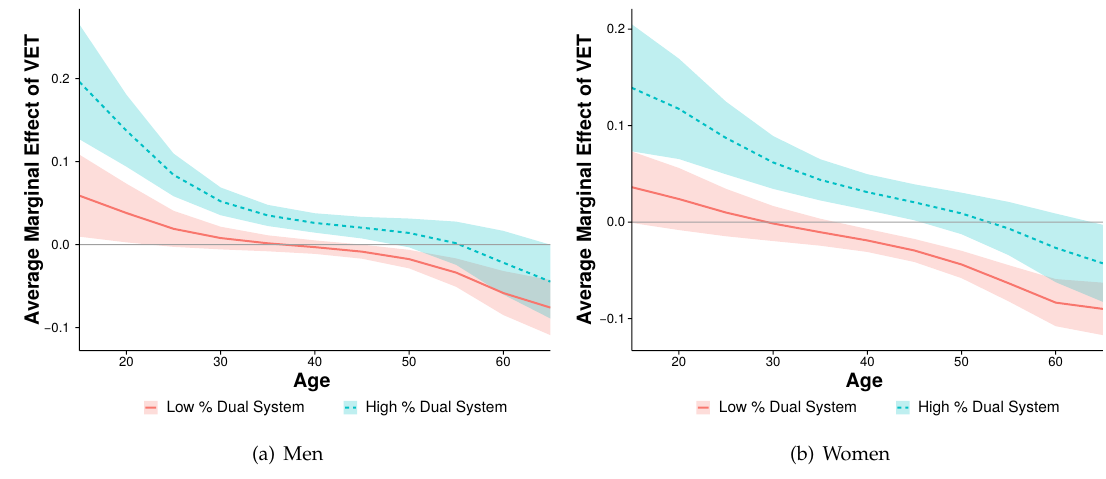
Figure 4: Average marginal effect of VET on employment in countries with low and high dual system